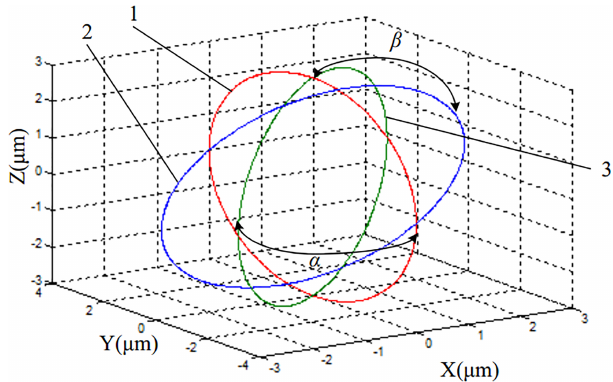
Figure 2. The tool trajectory of 3-D EVC.